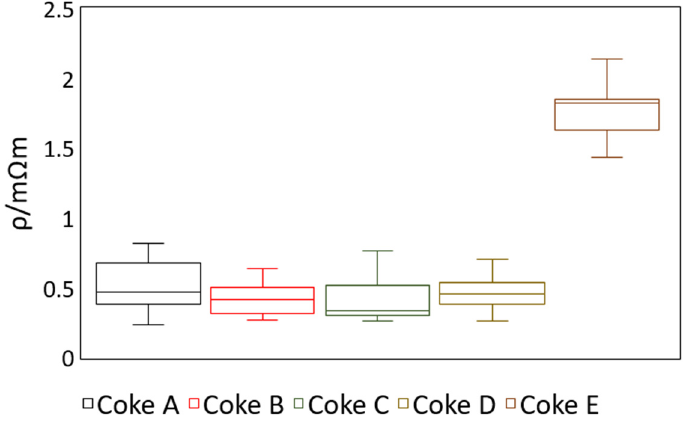
Figure 5. Room-temperature coke resistivity box-and-whisker plot. Sample size: 10 samples for each coke type.